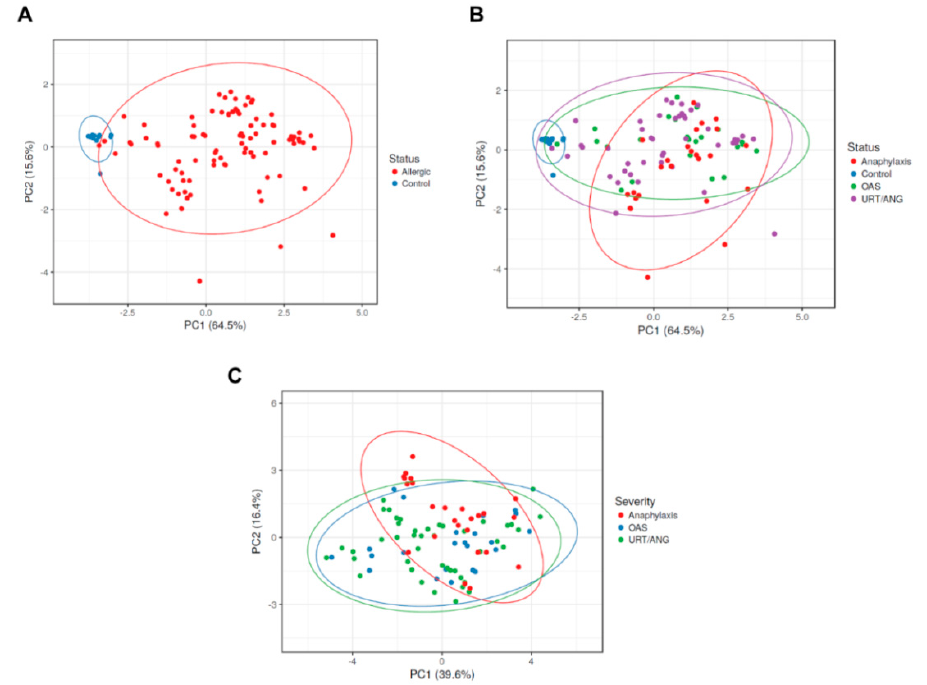
Figure 7. Principal component analysis is able to differentiate control subjects from peach-allergic patients, but not among patients grouped by symptoms. Using in vitro sIgE to Pru p 3, %CD63 + , and %CD203c high as variables to perform PCA, healthy controls were well differentiated from allergic patients ( A ). However, this fact did not occur among the severity groups ( B ), where more homogeneity was observed. ( C ) No separated clusters were obtained in the PCA performed with the variables in vitro sIgE to Pru p 3, wheal area, AUC, CD-sens, %CD63 + and %CD203c high , when severity groups were analyzed. OAS, oral allergy syndrome; PC, principal component; URT/ANG, urticaria/angioedema. Table 2. ROC curve parameters of % CD63 + and % CD203c high from Pru p 3. AUC